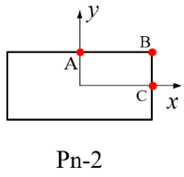
Figure 17. Local coordinate system of the connection components in the sections Pn-2.